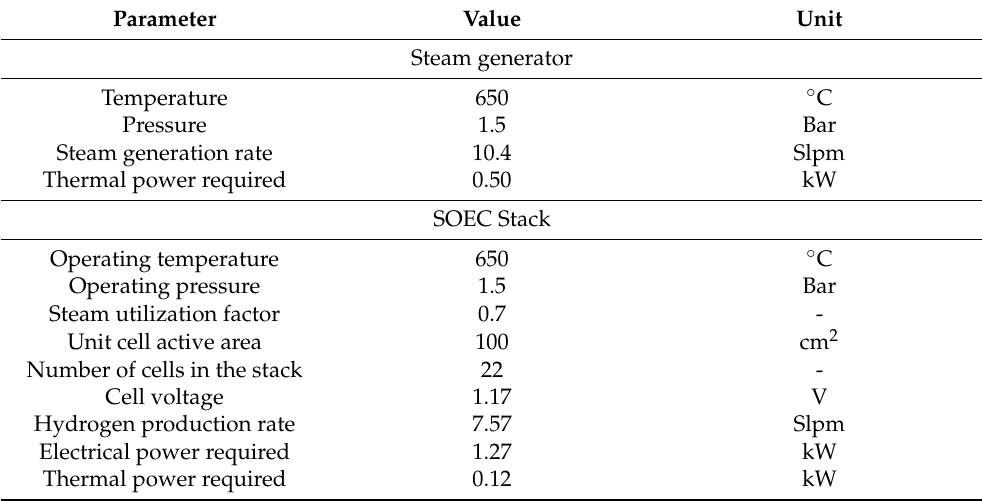
Table 6. Steam generator and SOEC simulation result in ASPEN